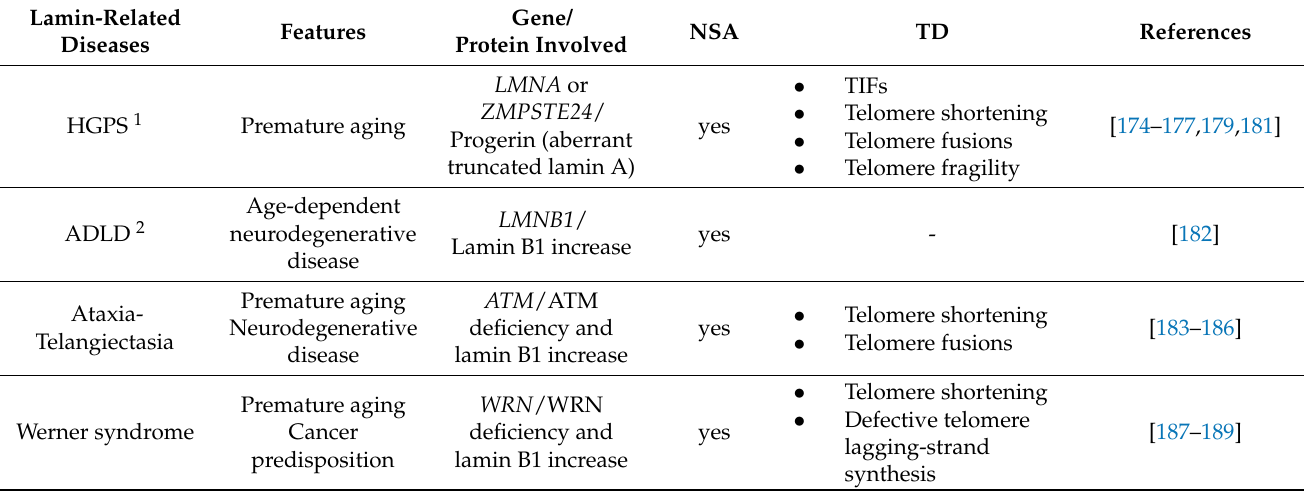
Table 2. Lamin-associated diseases, nuclear shape alterations (NSA), and telomere dysfunction